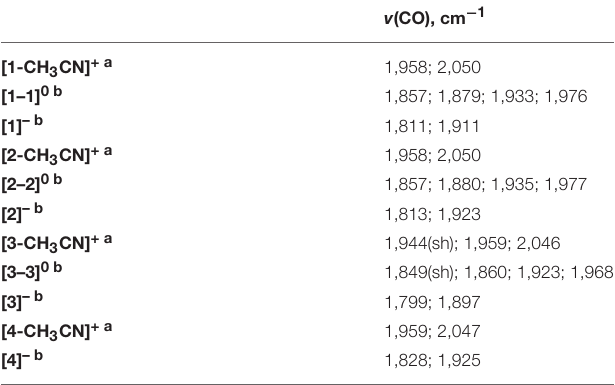
TABLE 2 | ν (CO) infrared stretches for [1-CH 3 CN] + , [2-CH 3 CN] + , [3-CH 3 CN] + , and [4-CH 3 CN] + precatalysts, and their one-electron reduced, dimeric, and two-electron reduced derivatives, obtained by solution phase FTIR and IR-SEC spectroscopy.